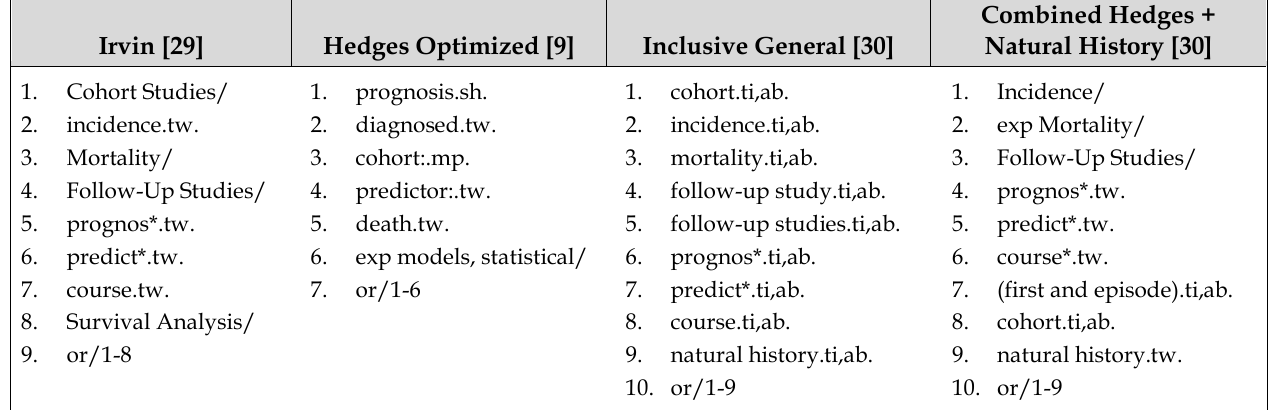
Table 1 Details of prognosis filters analyzed, Ovid MEDLINE